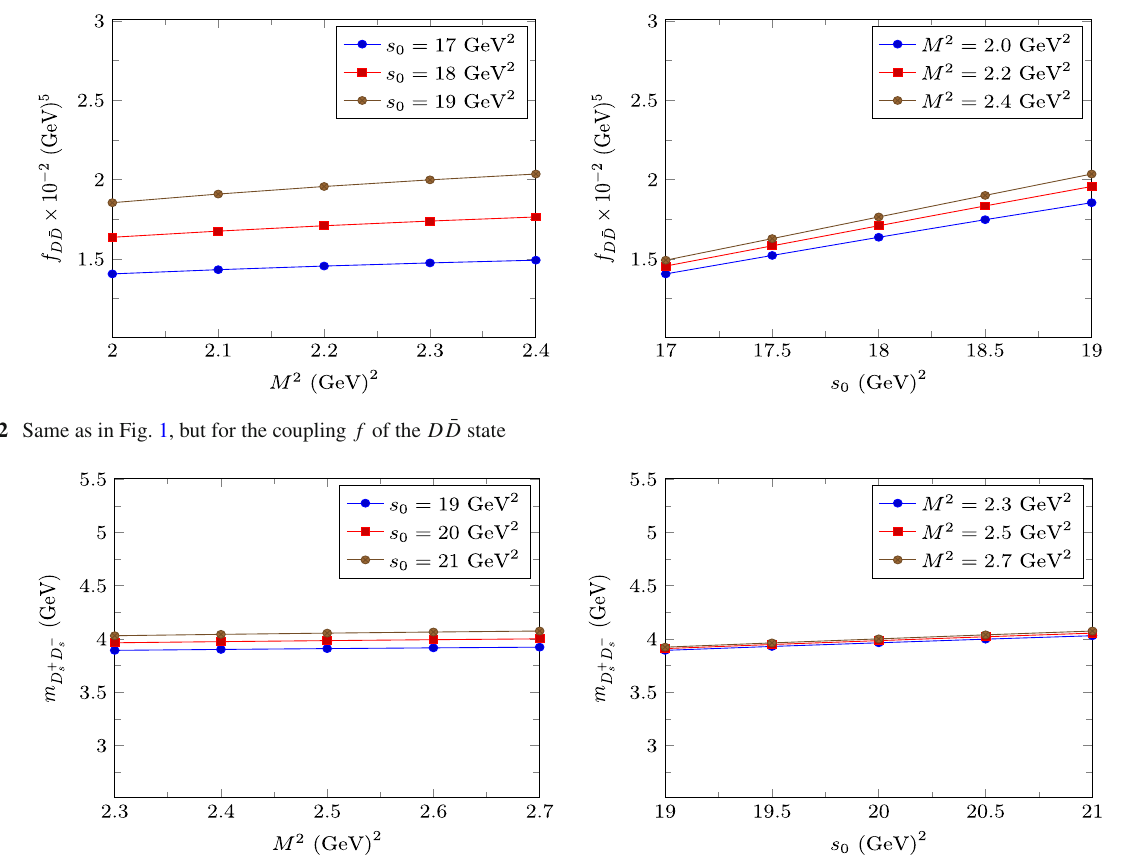
Fig. 3 The mass of the D + s D − s state as a function of M 2 at fixed s 0 (left panel), and as a function of s 0 at fixed M 2 (right panel)